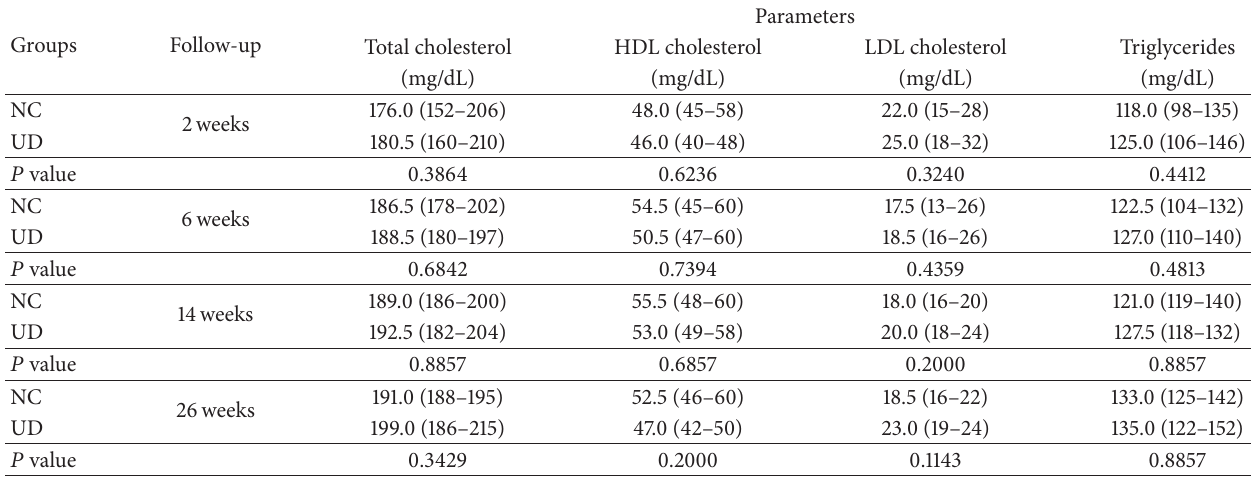
Table 2: Medians, maximum, and minimum values of parameters related to lipids profile of nondiabetic control and untreated diabetic rats during the various experimental follow-up periods.